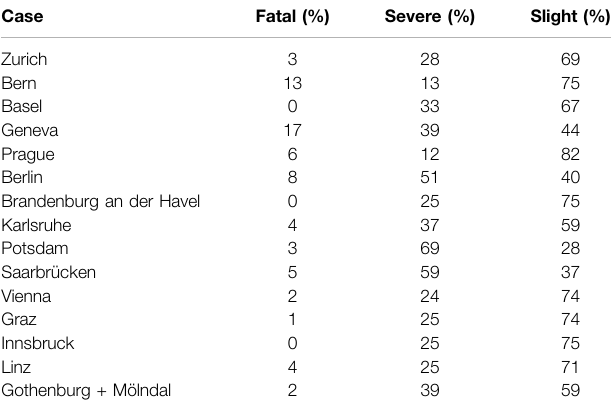
TABLE4| Severitydistributionofpedestrianinjuriesintram-pedestrianaccidents. Case